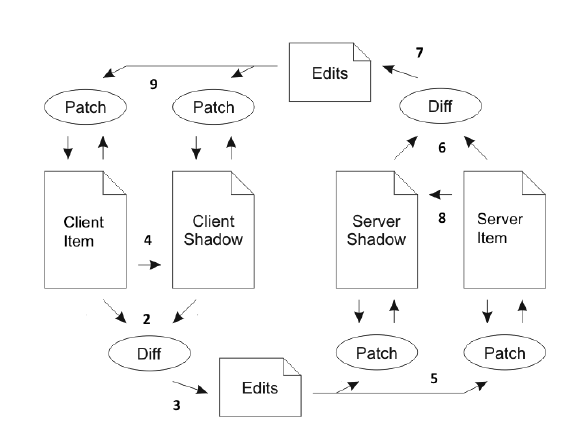
Figure 1. Differential synchronization with shadows - essentially corresponds to Fig.3 in [11] but the numbering and text have been